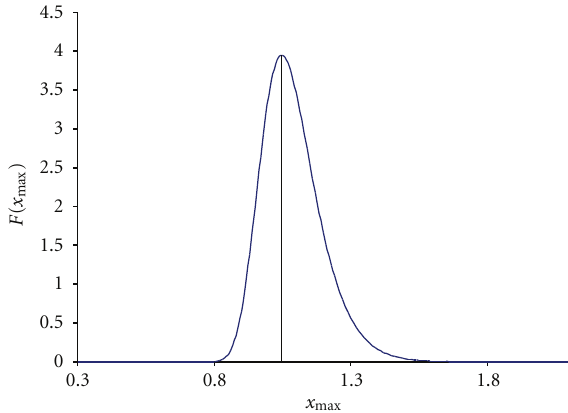
F 3: PWMS from random sequences follows approximately the normal distribution, based on 1000 random sequences of length 17 drawn from the pool of nucleotides with frequencies of A, C, G, and T equal to 0.3279, 0.1915, 0.2043, and 0.2763, respectively. e distribution has mean equal to 0.068884 and standard deviation equal to 0.314714254.